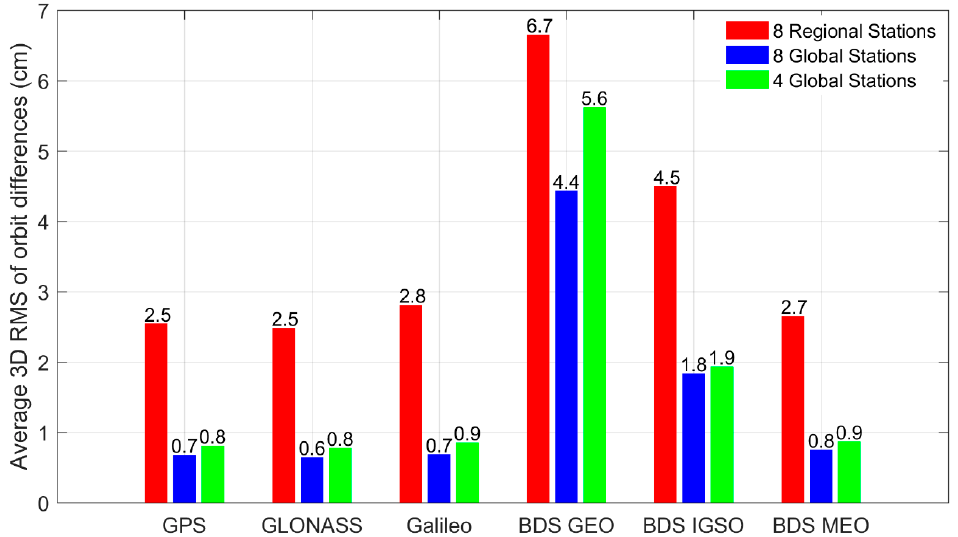
Figure 11. Average 3D orbit differences RMS of GNSS satellites for the integrated POD with a few ground stations. Values on the top of each bar indicates the corresponding average 3D RMS.